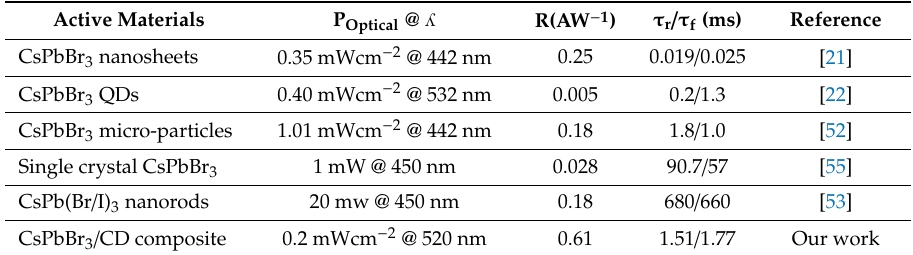
Figure 5. I–V curves of ( a ) CsPbBr 3 and ( b ) CsPbBr 3 / CD hybrid composite photodetectors under dark and illuminated (520 nm, 0.2 mWcm − 1 ) conditions. I –t curves of CsPbBr 3 and CsPbBr 3 / CD hybrid composite photodetectors ( c ), response times ( d ), rise times ( e ), and fall times ( f ) of the CsPbBr 3 / CD hybrid composite photodetector. Table 1. Summary of device performances of prepared perovskite photodetectors in the present work and the existing